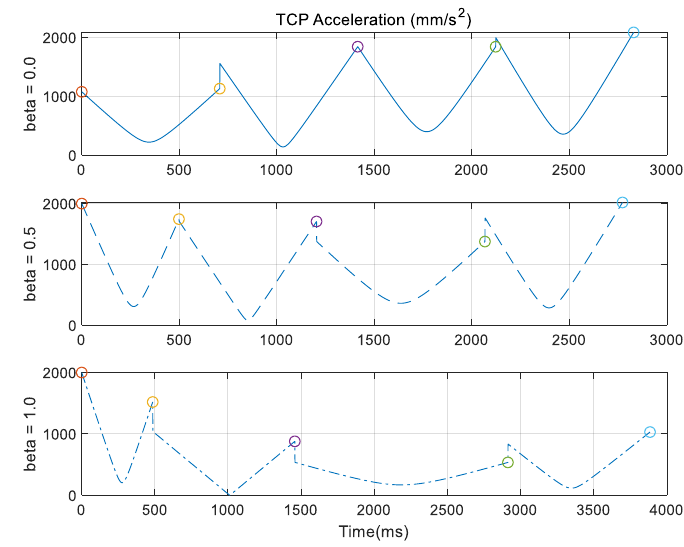
Figure 10. Acceleration according to β in the task #2.